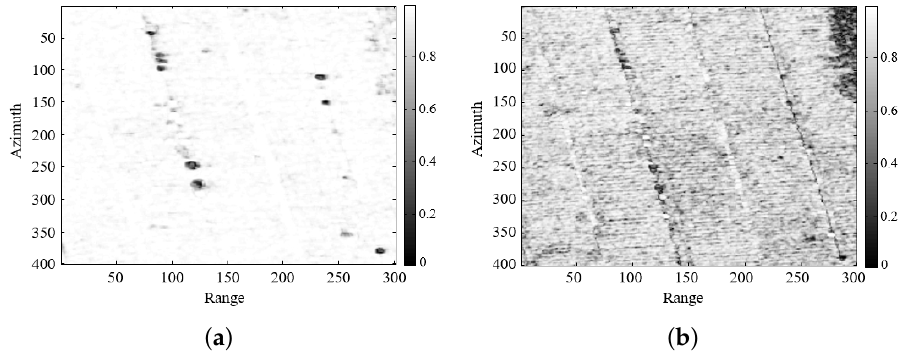
Figure 8. Coherence map of the vegetation region. ( a ) P-band and ( b ) C-band. Then, in order to show the difference between the P-band and the C-band on CCD more sufficiently, a detection result was obtained by thresholding the coherence map. The detection results for the P-band and the C-band are shown in Figure 9. The black area